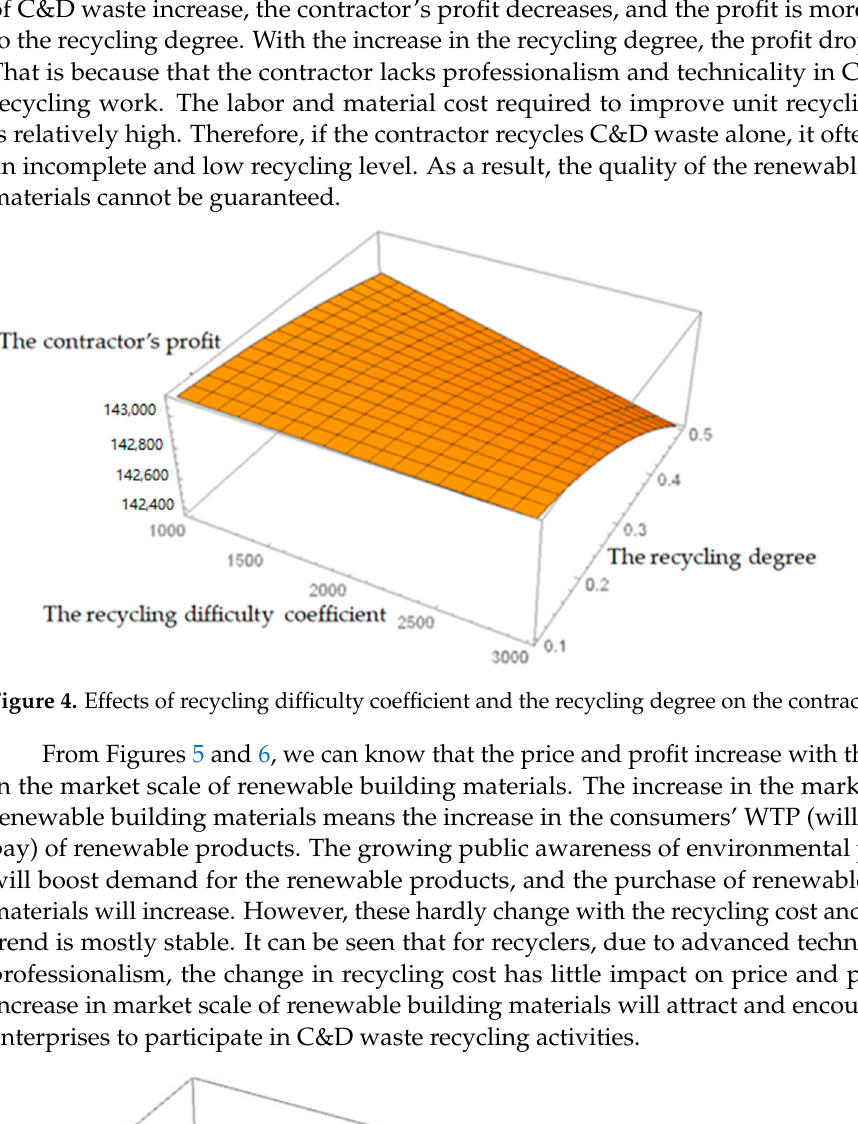
Figure 4. Effects of recycling difficulty coefficient and the recycling degree on the contractor’s profit.